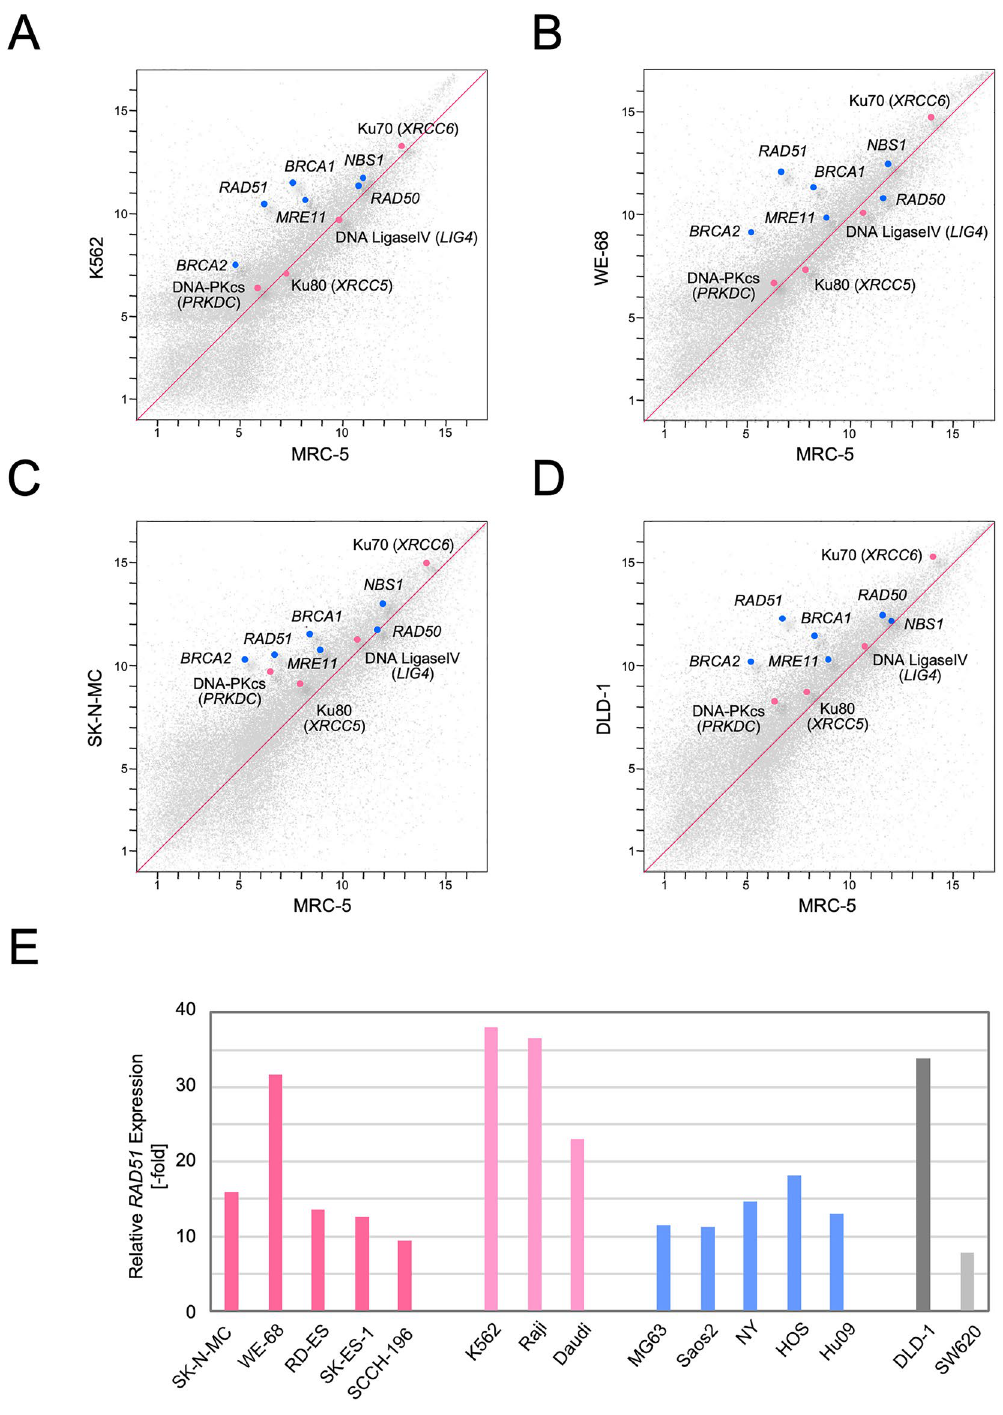
Figure 1. Expression microarray analyses of TL + human tumor cell lines. Using an expression microarray, mRNA expression was profiled in the TL + leukemia cell line, K562 ( A ), the two TL + Ewing sarcoma cell lines, WE-68 ( B ) and SK-N-MC ( C ), and DNA mismatch repair (MMR)-defective colorectal cancer cell line, DLD-1 ( D ). Expression levels of mRNAs were compared with those in a primary culture of normal human fibroblasts, MRC-5, and the results were shown in scatter plots. The expression levels of the RAD51 gene were extracted and compared among various human tumor cell lines ( E